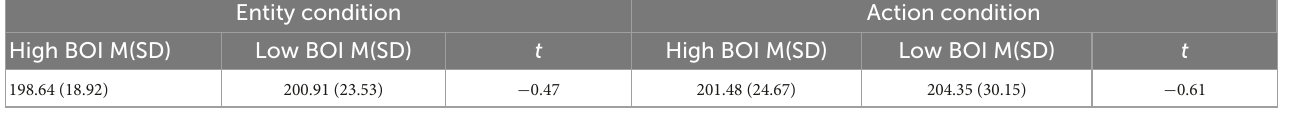
TABLE 5 P2 mean peak latency, standard deviations, and t -tests by task condition and word type. Entity condition Action condition High BOI M(SD)